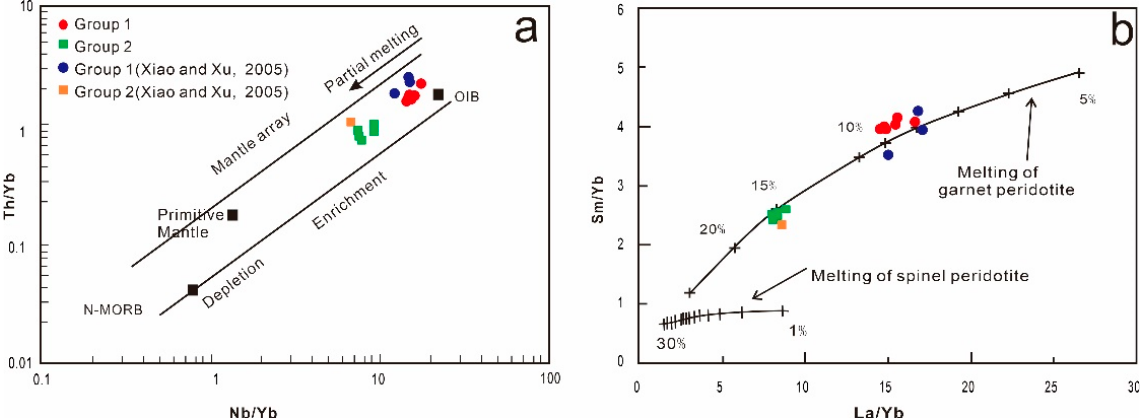
Figure 11. ( a ) Nb/Yb vs. Th/Yb diagram [16]; ( b ) Sm/Yb vs. La/Yb plot for Dashibao basalts in the Xindianzi area [80].